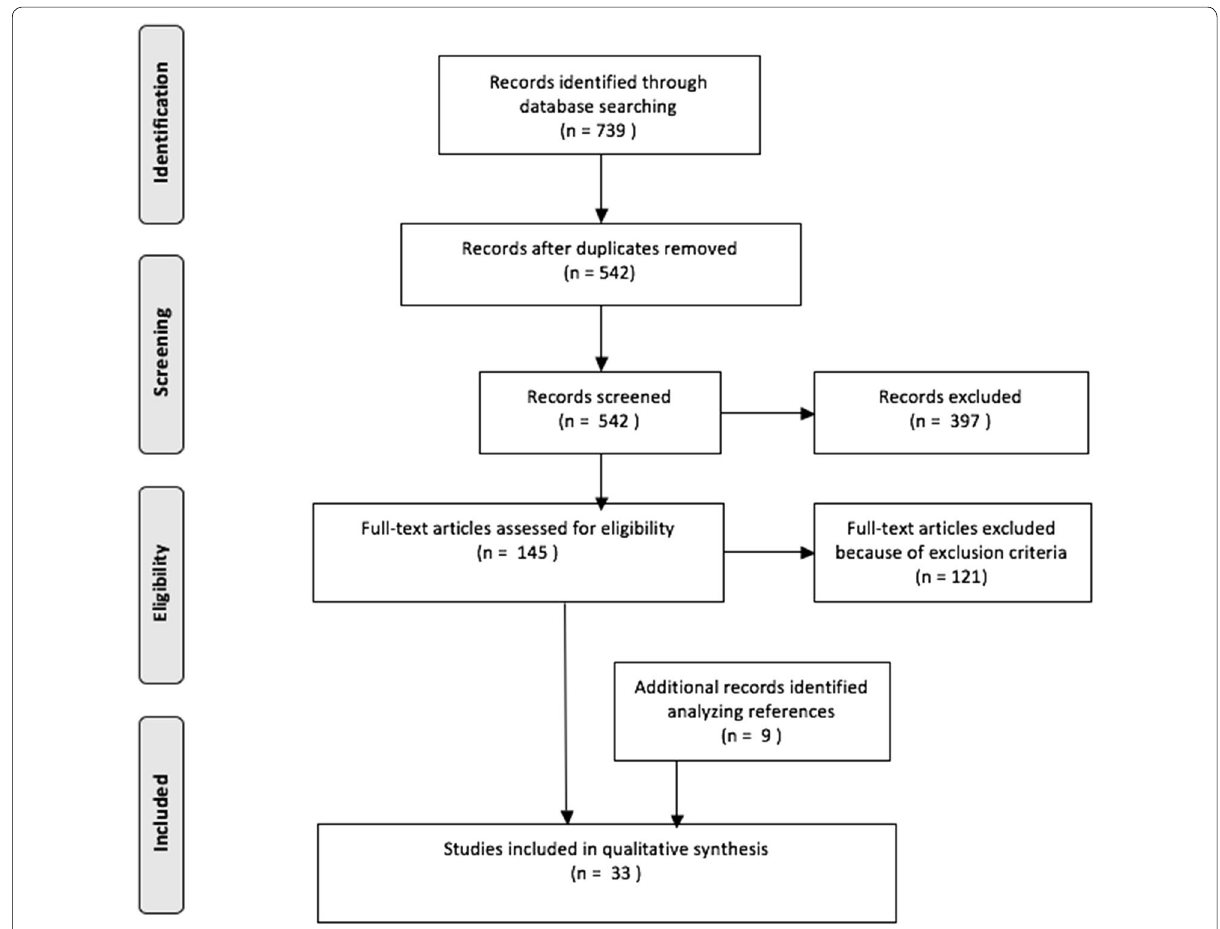
Fig. 1 Flow chart of selection procedure of the reviewed papers